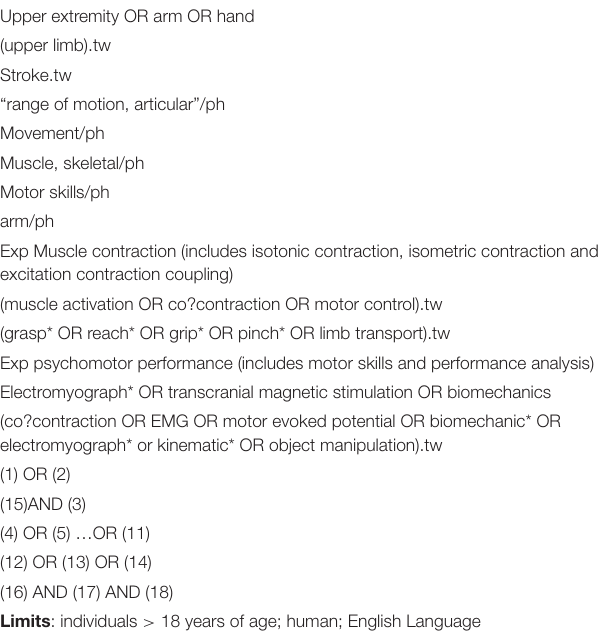
TABLE 1 | The search strategy used to search the database MEDLINE as example of electronic searches. Upper extremity OR arm OR hand (upper